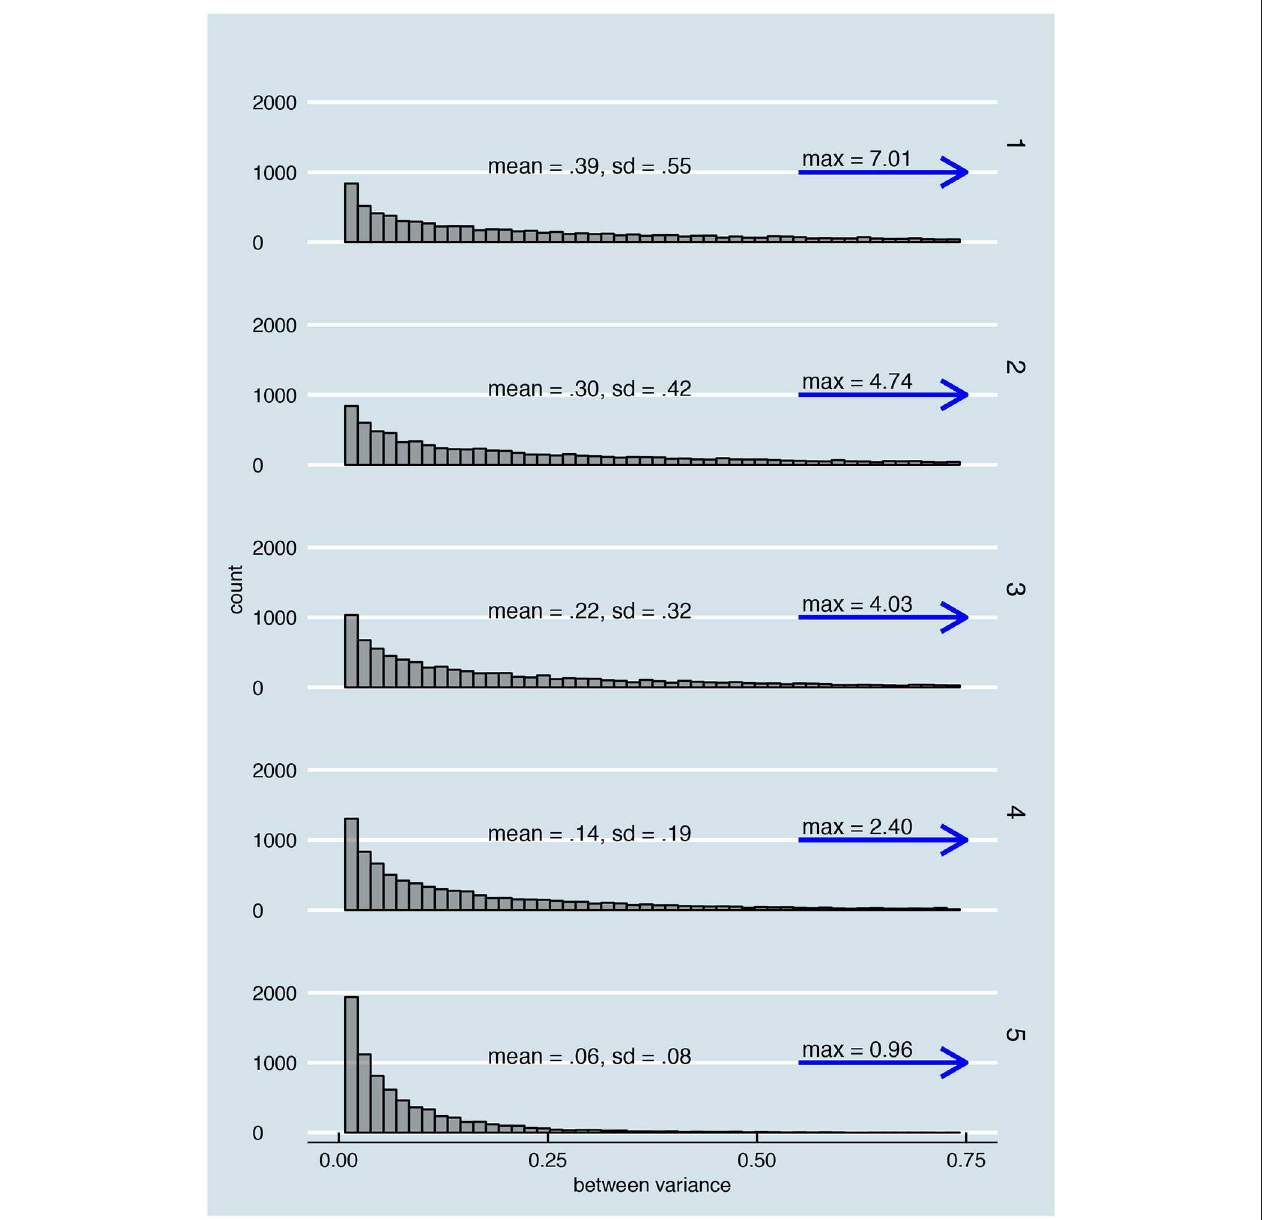
FIGURE 13 | Overlap in the distributions of possible between variances for 5 examinees with underlying error variances 0.75 (examinee 1), 0.60 (examinee 2), 0.44 (examinee 3), 0.28 (examinee 4), and 0.12 (examinee